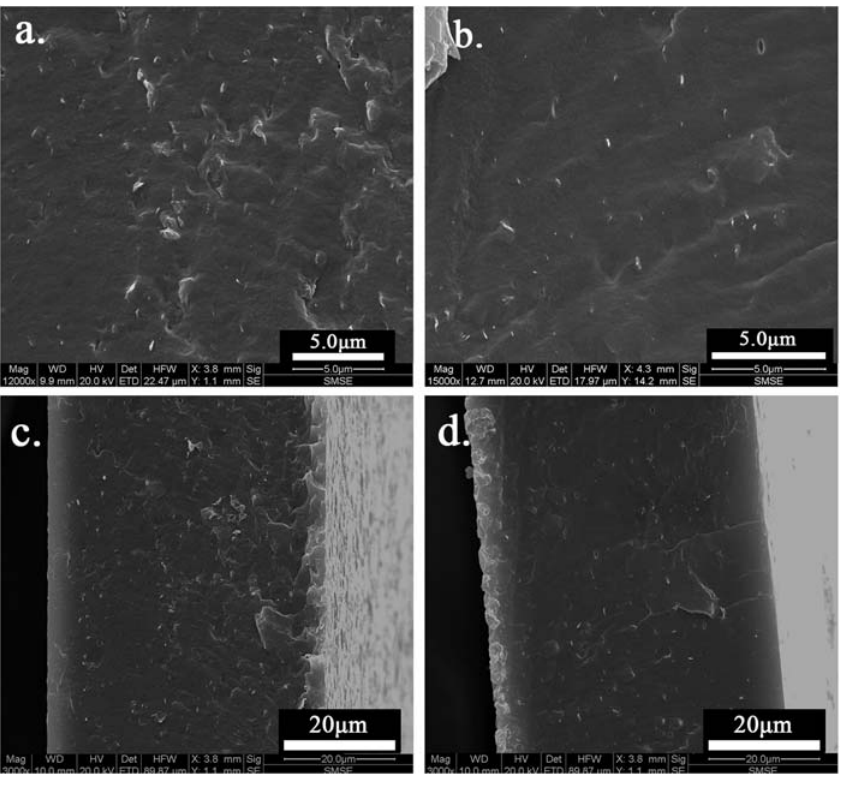
Figure 10: SEM images of the cross - section of the MMMs containing 6.5 wt%: ( a and c ) pristine MMT, ( b and d ) APOP - MMT.